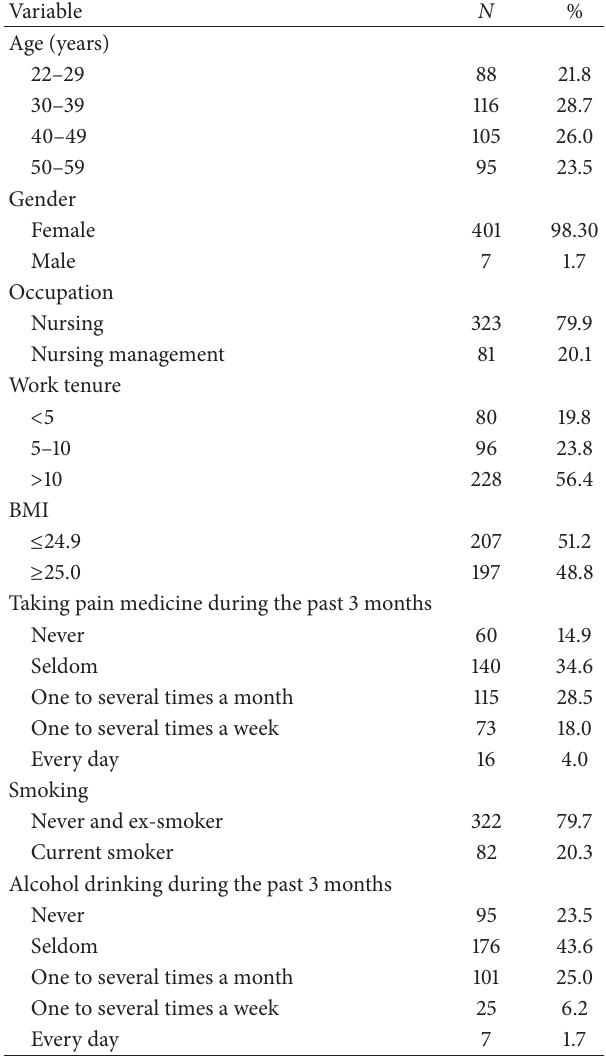
Table 1: Participants’ demographic and lifestyle